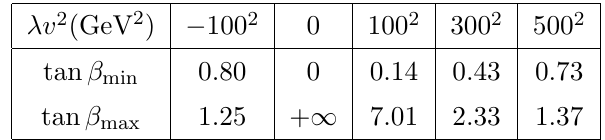
Table 4 . A few benchmark values for (cid:21)v 2 , and the corresponding range of tan (cid:12) given the theoretical